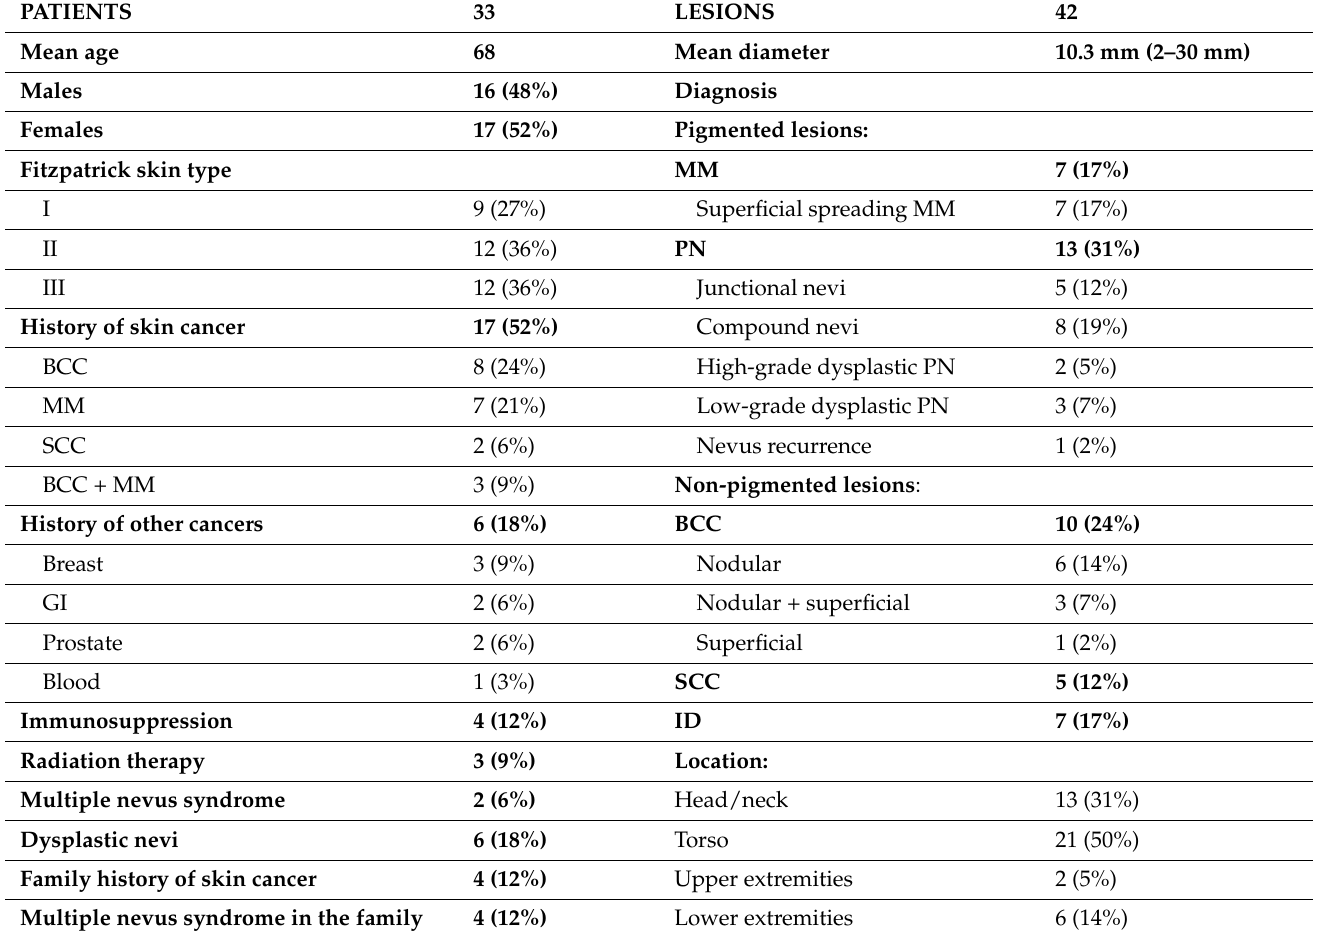
Table 1. Patient demographics and lesion characteristics ( n ,